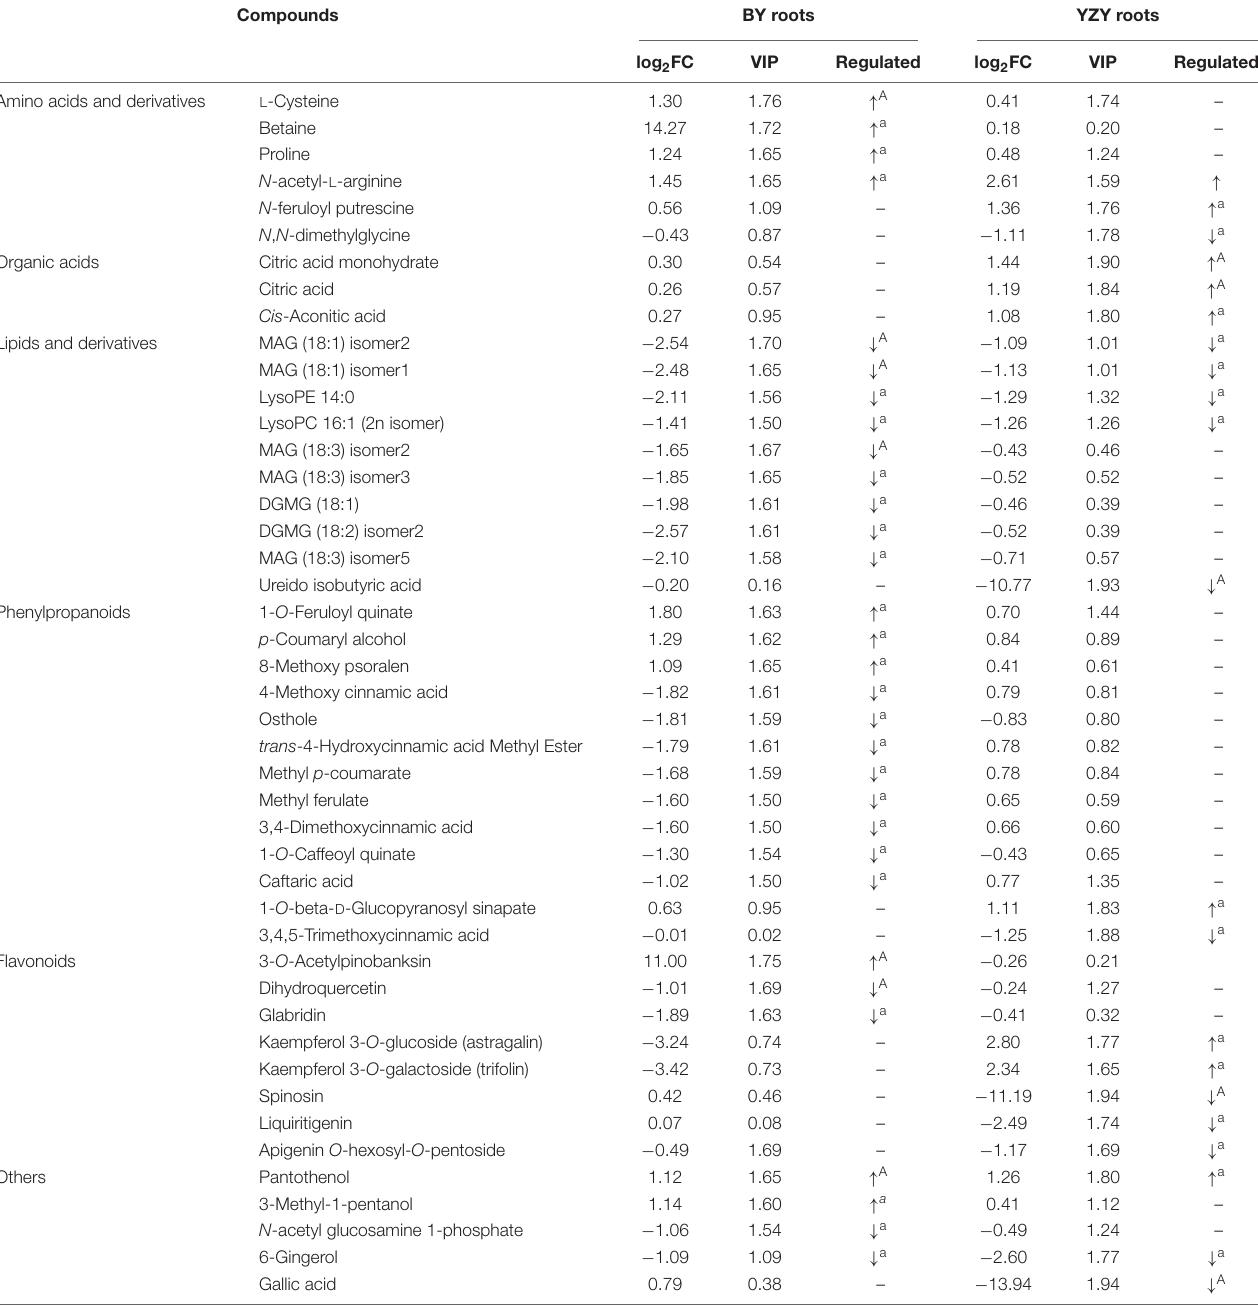
TABLE 2 | The significant differential abundant metabolites in roots of Baiyan7 (BY) or Yizhangyan4 (YZY) after saline-alkali stress. Compounds BY